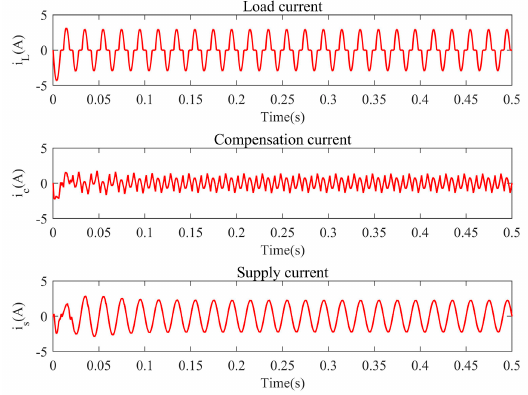
Figure 4. Current curves of steady-state response.